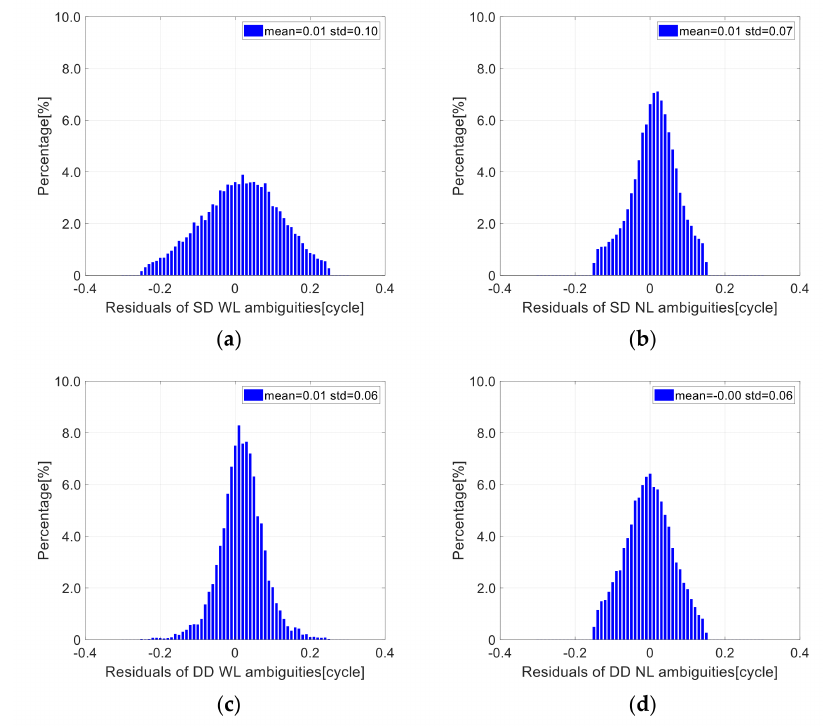
Figure 5. Residual distributions of ( a ) SD WL, ( b ) SD NL, ( c ) DD WL, and ( d ) DD NL ambiguities of GRACE-FO